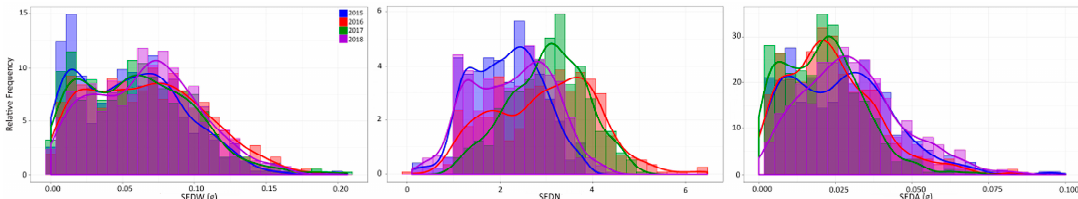
Figure 1. Distribution of the MA × CS progeny ( n = 573) for SEDW, SEDN, and SEDA across four evaluated seasons. Graphs are presented as overlapped blue, red, green, and purple bar graphs for 2015, 2016, 2017, and 2018 seasons, respectively.